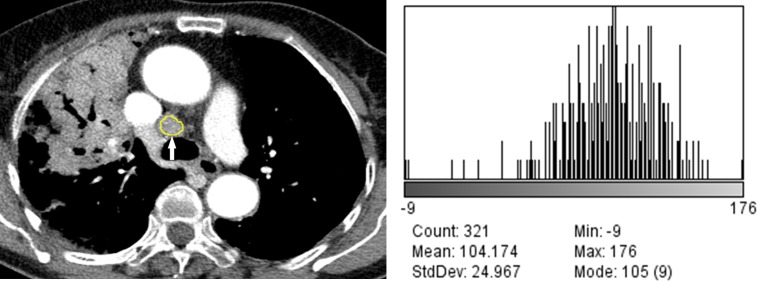
76-year-old woman with tuberculous lymphadenopathy with lung involvement.(A) Mediastinal window image of contrast-enhanced chest CT scan shows a segmented right lower paratracheal lymph node (arrow). (B) Histogram plot shows the CT data profile of the segmented lymph node (skewness, -1.14; kurtosis, 2.86).